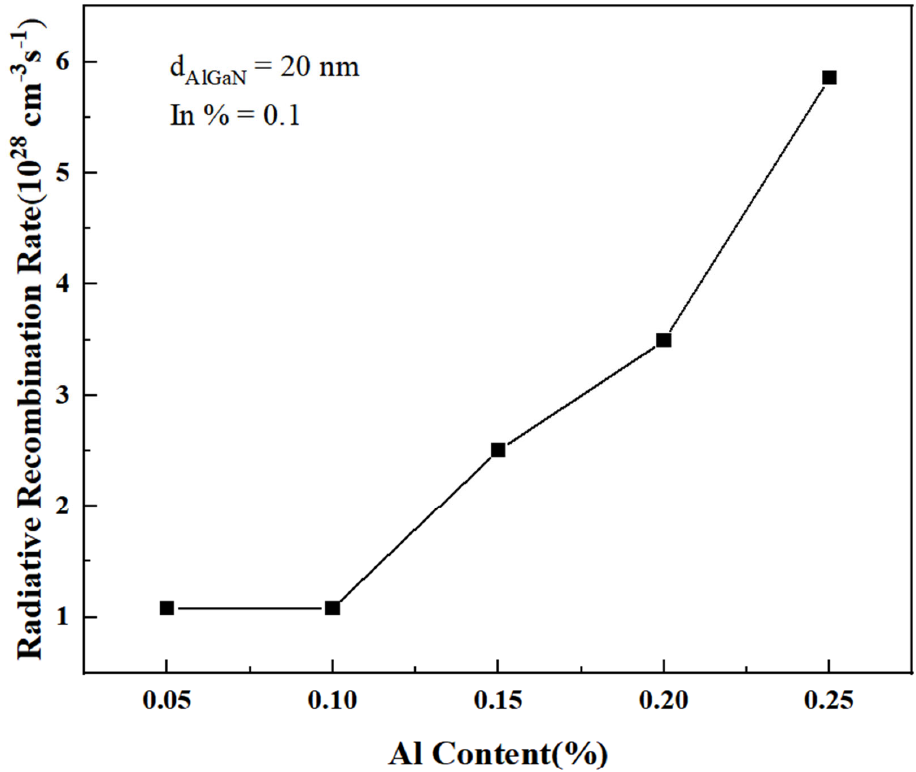
Figure 14. Calculated radiation recombination rate at different Al